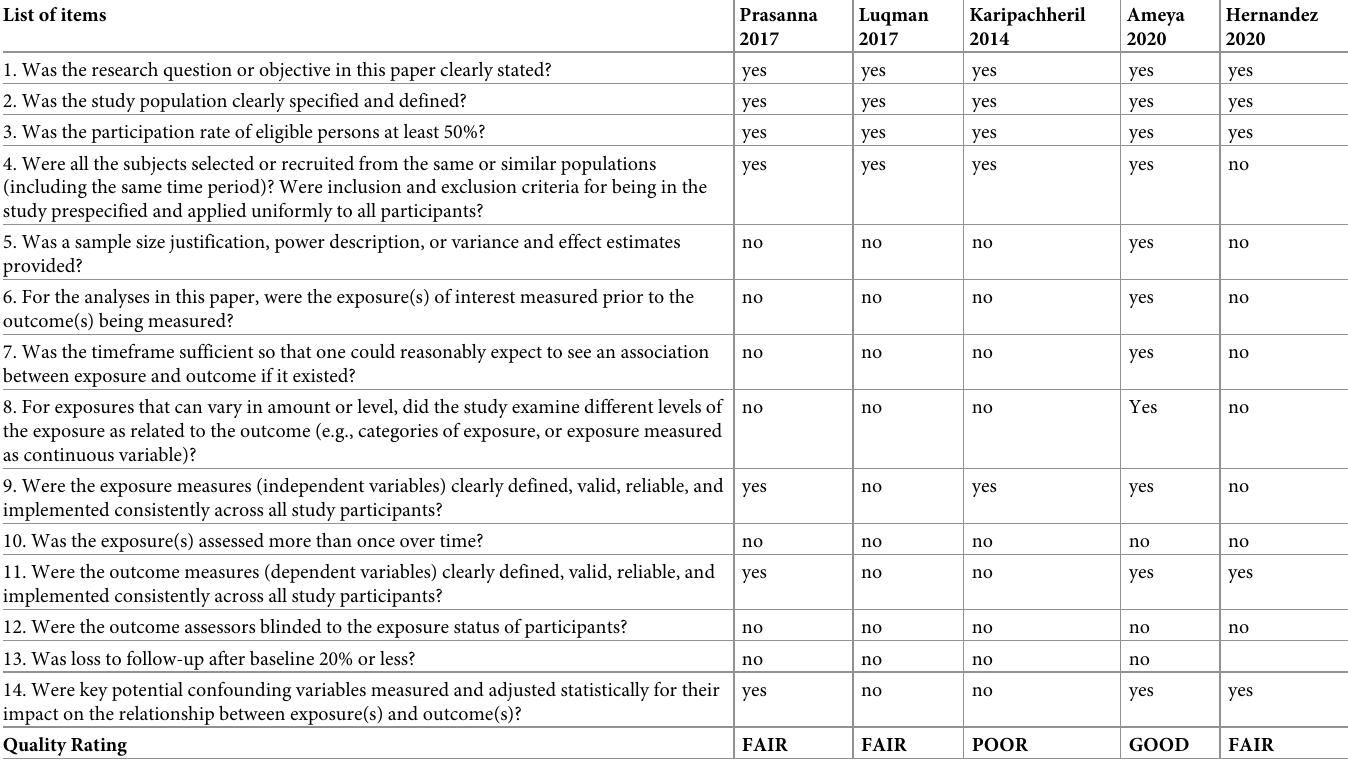
Table 2. Risk of bias assessment according to National Institute of Health quality assessment tool for cross-sectional